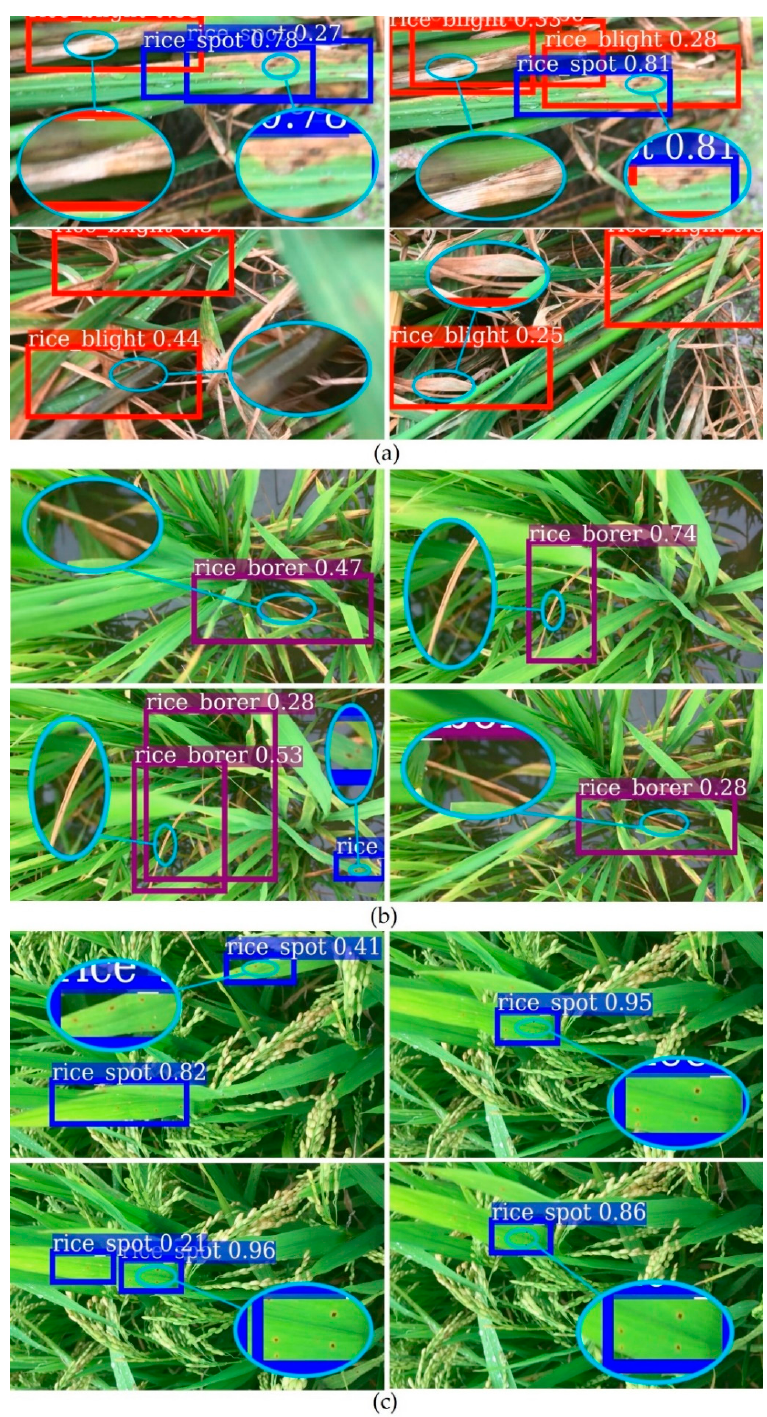
Figure 6. The custom DCNN video detection system results, ( a ) Video 1, which mainly has rice sheath blight. ( b ) Video 2, which mainly has rice stem borer symptoms. ( c ) Video 3, which mainly has rice brown spot. Each video has three categories of rice disease and pest symptoms. Red, purple and blue boxes denote rice sheath blight, rice stem borer symptoms, and rice brown spot respectively. Indigo ellipses magnify the lesion spots, which is realized by Adobe Photoshop CS6. The same kind of lesions is magnified once in each subgraph. Videos 1–3 were not used in the model training. Video 1 and Video 3 were captured in Hunan Province, China, July 2018, Video 2 was captured in Jiangxi Province, China, July